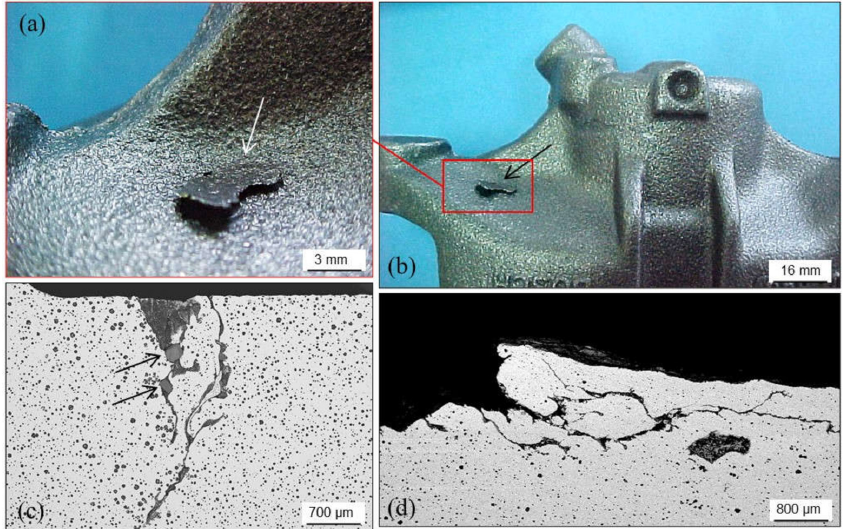
Figure 38. Lustrous carbon inclusions in ductile iron castings: ( a , b ) automotive caliper, and ( c , d ) metallographic cross section view of this